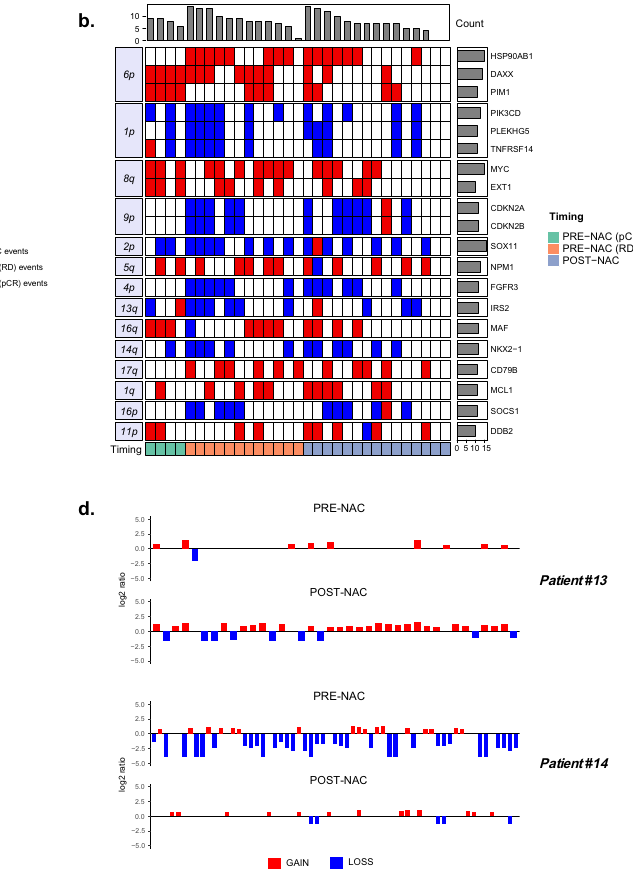
Figure 1. Copy number alteration (CNA) analysis of TNBC before and after neoadjuvant chemotherapy (NAC). ( a ) Barplot showing detection of CNA events obtained from all patients in the cohort. X-axis reports the genomic regions present in CCP panel divided by chromosomes while y-axis reports their absolute number of alterations by different sample type. “No events” refers to genomic regions with no alterations detected ( b ) Top 20 altered genes in the study cohort. The heatmap reports in the columns the pre- and post-NAC samples and in the rows the altered genes by chromosomal arms. Red and blue colors refer to amplification and deletion events respectively. ( c ) Box plot comparing pre- and post-NAC samples alterations (gain = red, loss = blue) in patients with matched tumors. ( d ) CNA plot for patients #13 and #14. Vertical lines represents the log2 ratio of gene copy number colored based on its status (amplification = red; deletions =